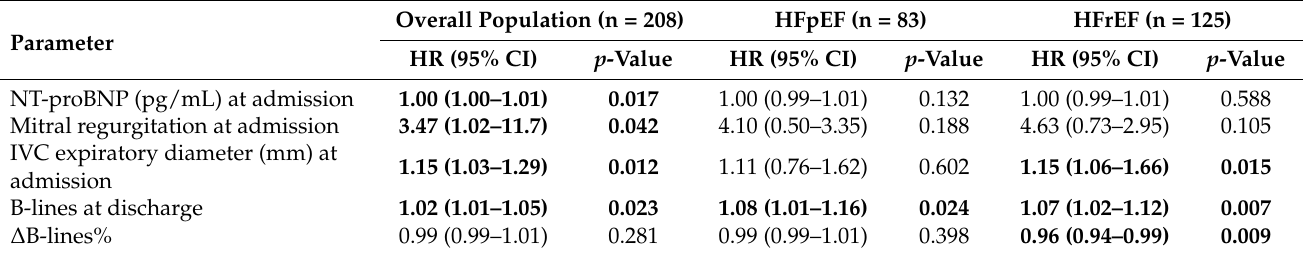
Table 4. Multivariate predictors of the composite endpoint (cardiovascular death and re-hospitalization for worsening heart failure) at 6-month